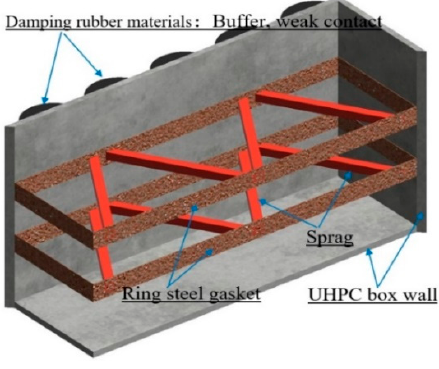
Figure 5. Internal structure of No.3box.